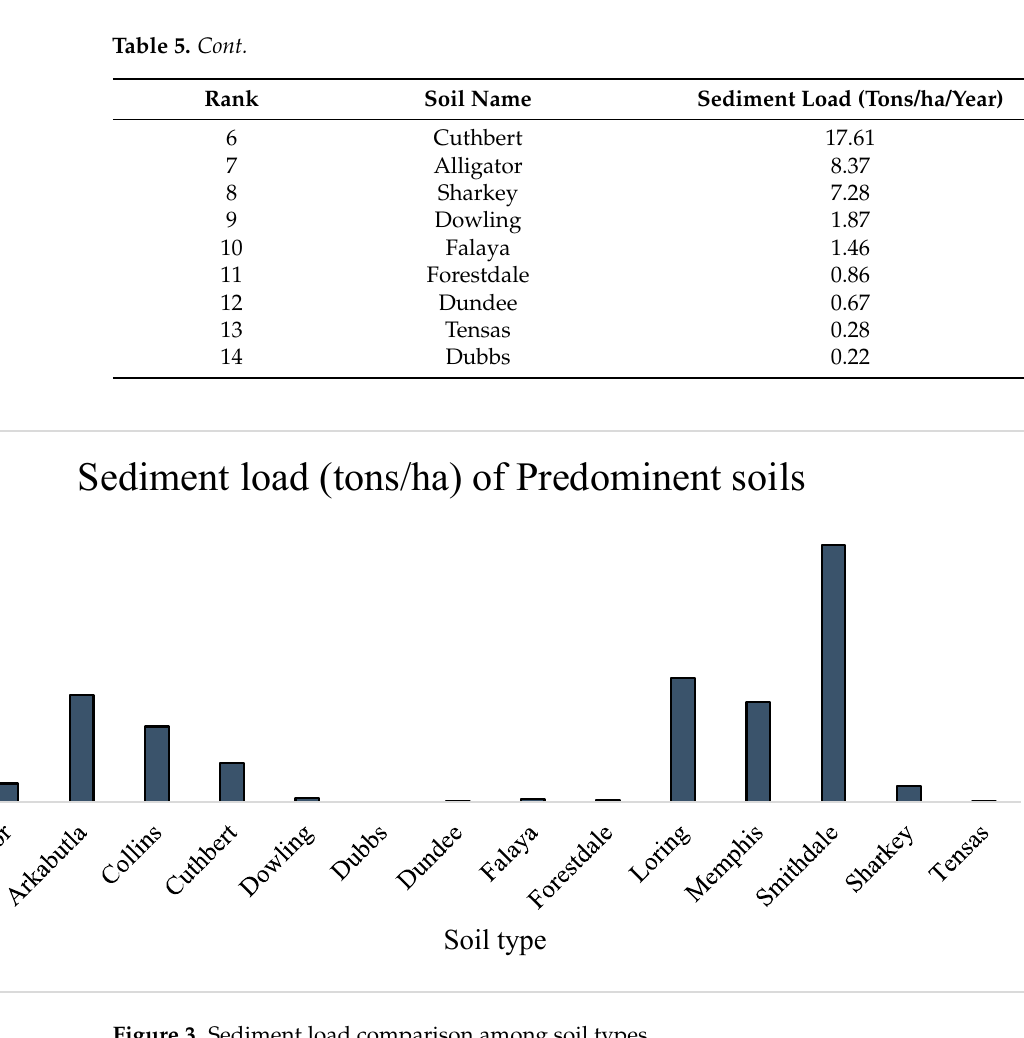
Table 6. Major soils with major agricultural land use.